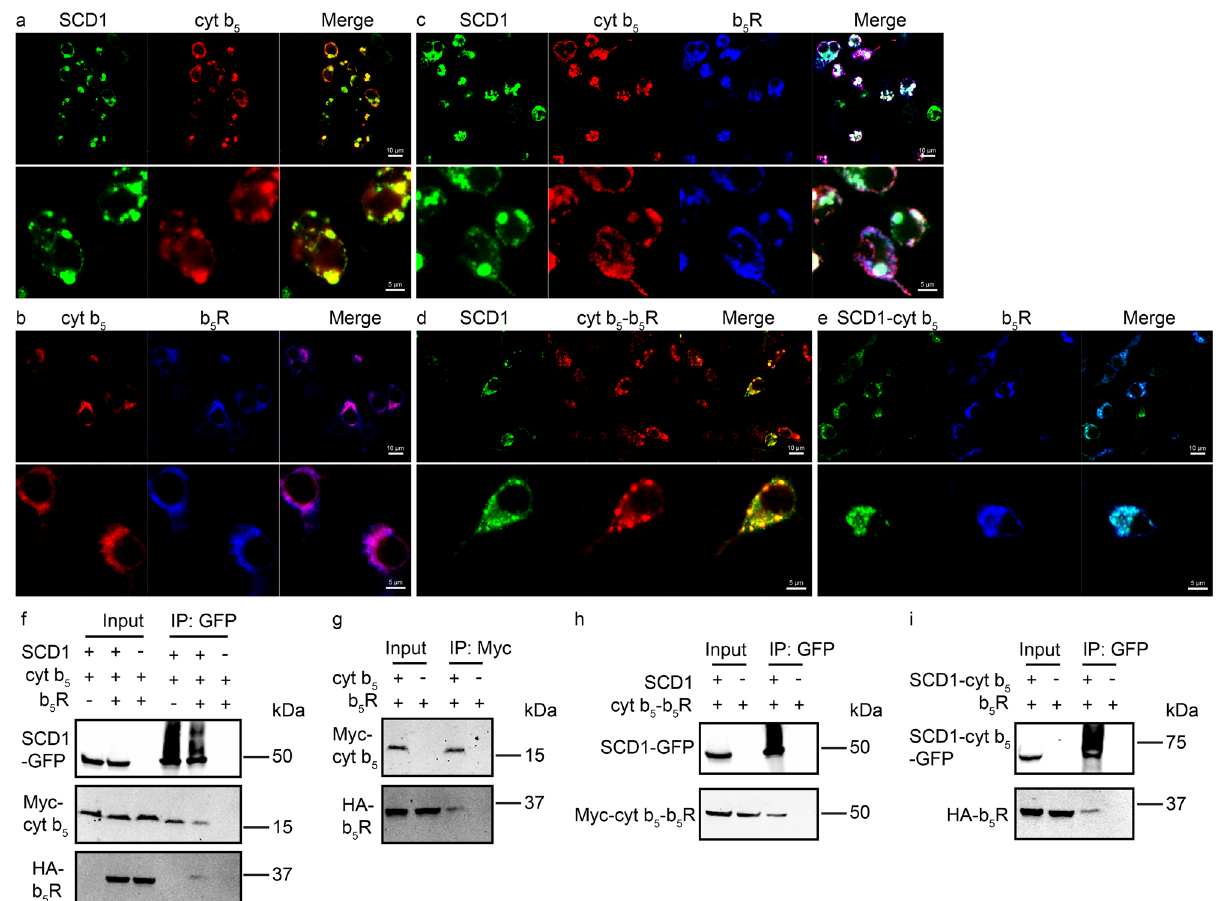
Fig. 2 Colocalization and co-immunoprecipitation (co-IP) of SCD1, cyt b5, b5R, and their binary fusions. Confocal microscopy images show the subcellular distribution and colocalization of a SCD1-GFP (green) and Myc-cyt b 5 (red); b Myc-cyt b 5 (red) and HA-b 5 R (blue); c SCD1-GFP (green), Myc- cyt b 5 (red), and HA-b 5 R (blue); d SCD1-GFP (green) and Myc-cyt b 5 -b 5 R (red); e SCD1-cyt b 5 -GFP (green) and HA-b 5 R (blue). a – e Images in the top and bottom panels are from the same samples of different magni fi cations. White scale bars represent 10 µ m for the top panels and 5 µ m for the bottom panels. f Co-IP of SCD1, cyt b 5 , and b 5 R. Cells co-expressing SCD1-GFP and Myc-cyt b 5 (left lane) were solubilized, and the lysate was immunoprecipitated with GFP nanobody-conjugated resins. Detection of Myc-cyt b 5 after extensive wash of the resins indicates some stable complex assembly between SCD1 and cyt b 5 . Similarly, ternary complex formation was demonstrated from cells co-expressing tagged SCD1, cyt b 5 , and b 5 R (middle lanes). The lysate from cells expressing tagged cyt b 5 and b 5 R (right lane) served as a negative control to exclude the possibility of non-speci fi c binding of cyt b 5 and b 5 R to resins and non-speci fi city of antibodies used in western blots. g Co-IP of cyt b 5 and b 5 R shows the existence of some stable cyt b 5 -b 5 R complex. Unlike in f , lysates were immunoprecipitated with anti-Myc antibodies and protein A resins to capture Myc-cyt b 5 . h Co-IP of SCD1 with the binary fusion of cyt b 5 -b 5 R. i Co- IP of the binary fusion of SCD1-cyt b 5 with b 5 R. For all the input lanes, 6% of cell lysate was loaded. IP, immunoprecipitation. All the data are from one representative experiment of at least two independent